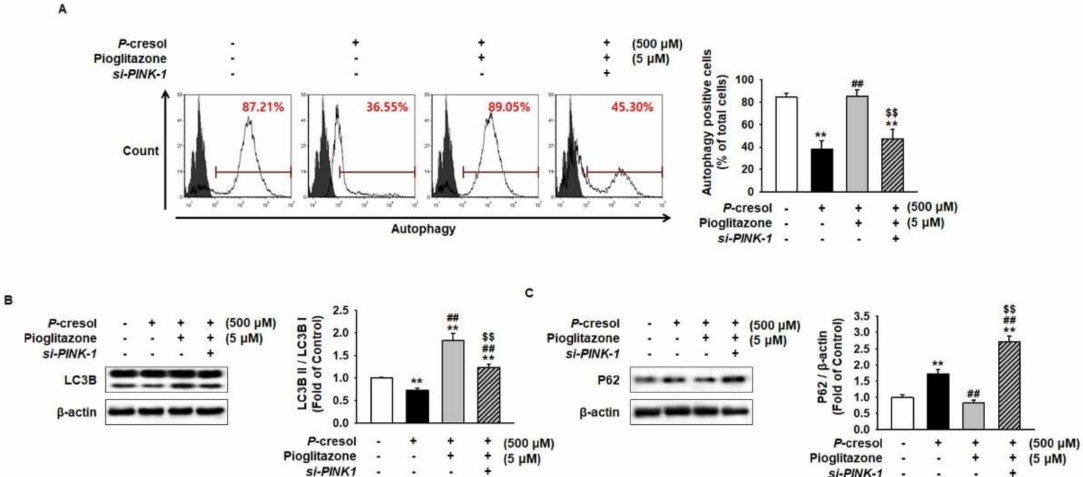
Figure 4. Pioglitazone-treated MSCs increased mitophagy by increasing PINK-1 on exposure to PC. ( A ) Autophagy was measured by lysosomal/autophagic vacuole fluorescent staining. Values represent the mean ± SEM. ** p < 0.01 vs. untreated MSCs, ## p < 0.01 vs. MSCs exposed to PC, $$ p < 0.01 vs. MSCs treated with pioglitazone. ( B , C ) After the 72 h PC (500 µ M) exposure, Western blot was used to analyze the expression of LC3B and P62 in MSCs after 24 h treatment of si-PRNP -transfected MSCs with pioglitazone (5 µ M; 24 h). The expression levels were determined by densitometry relative to β -actin. Values represent the mean ± SEM. ** p < 0.01 vs. untreated MSCs, ## p < 0.01 vs.